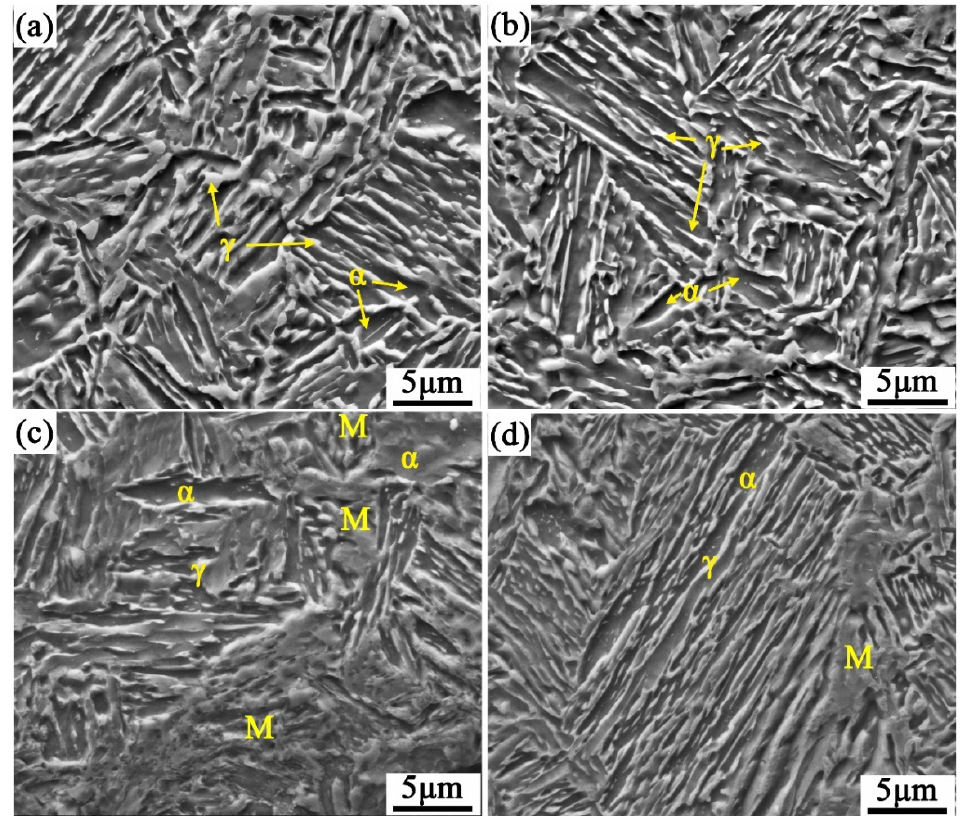
Figure 7. SEM micrographs of CQ2-ART ( a ) and CQ3-ART ( b ) samples before the tensile tests; ( c,d ) the corresponding samples after the tensile tests.